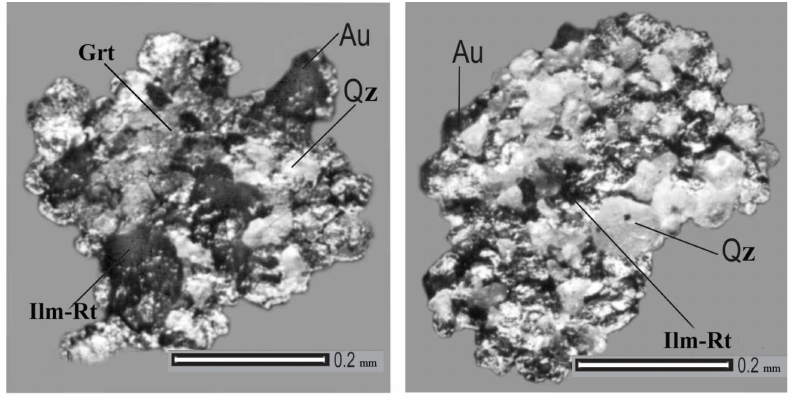
Figure 2. Pseudo-growths of native gold with quartz (Qz), ilmenorutile (Ilm-Rt) and garnet